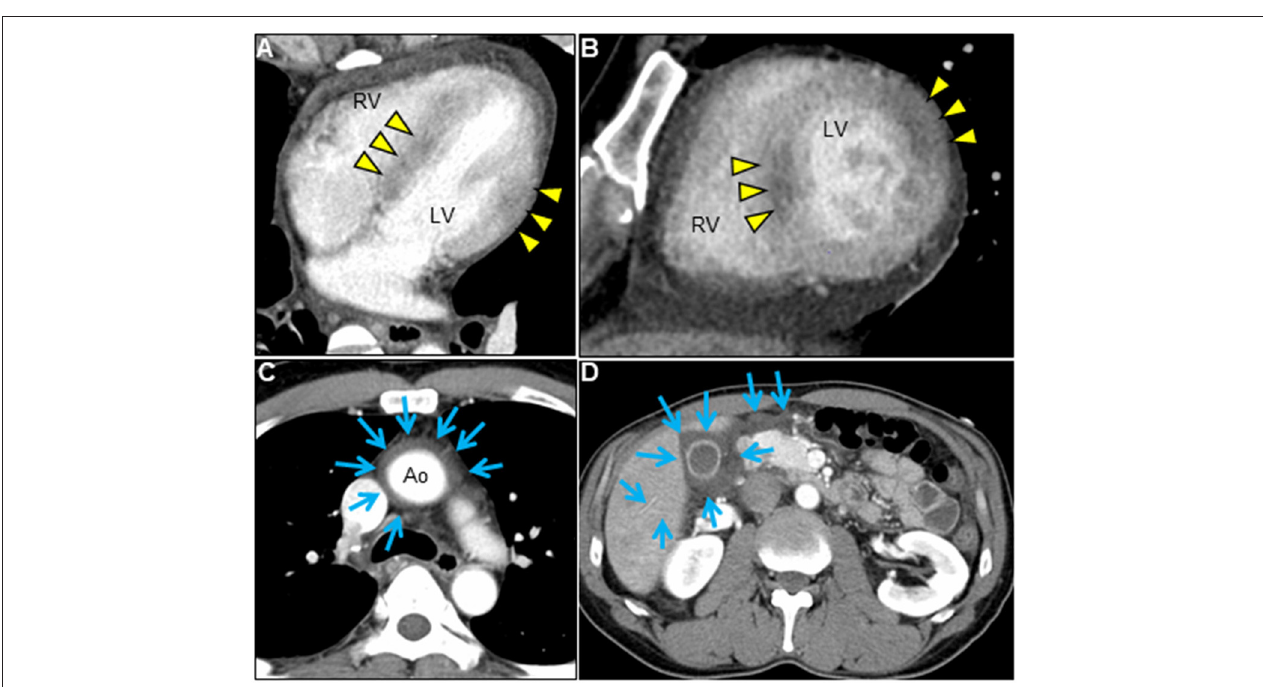
FIGURE 3 | Chest/abdominal contrast-enhanced CT images. Axial (A,C,D) and sagittal (B) views. Contrast-enhanced CT reveals LV wall thickening with pericardial effusion, decreased myocardial enhancement of both mid-layer in the basal-to-mid septal wall and transmural myocardium in the mid anterolateral wall ( A,B , arrowheads), and fluid accumulation in pericardial sinuses ( C , arrows). Airless low-attenuating areas in the region of gallbladder wall thickening and around the hepatic round ligament and periportal space, indicating marked systemic edema ( D , arrows). CT, computed tomography; Ao, aorta; LV, left ventricle; RV, right ventricle.